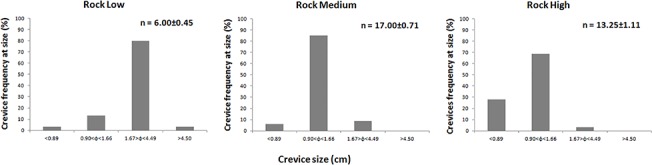
Mean number (n) ± standard error and frequency distribution of crevices according to four size classes at each of the three levels of rocky substrate complexity.